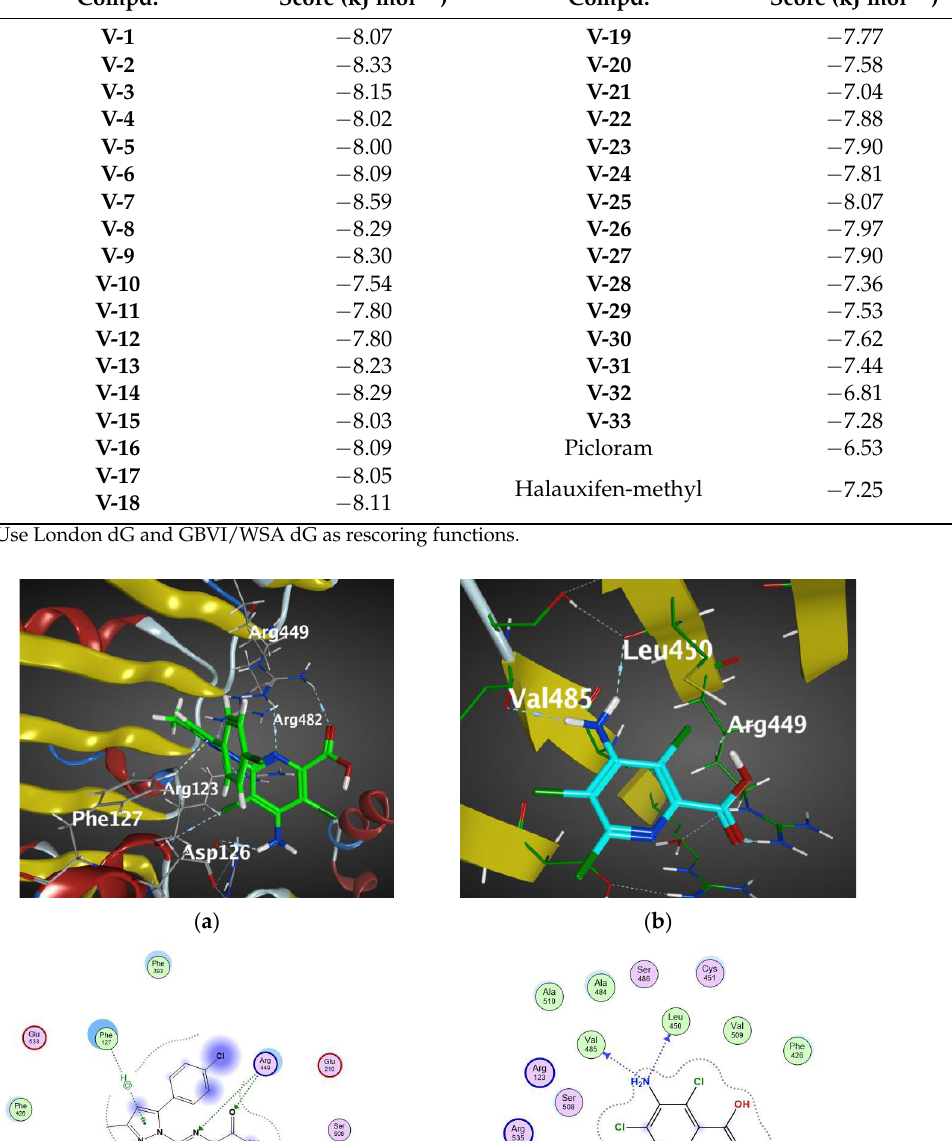
Table 1. Predicted binding energy of all target compounds, picloram, and halauxifen-methyl. Compd.